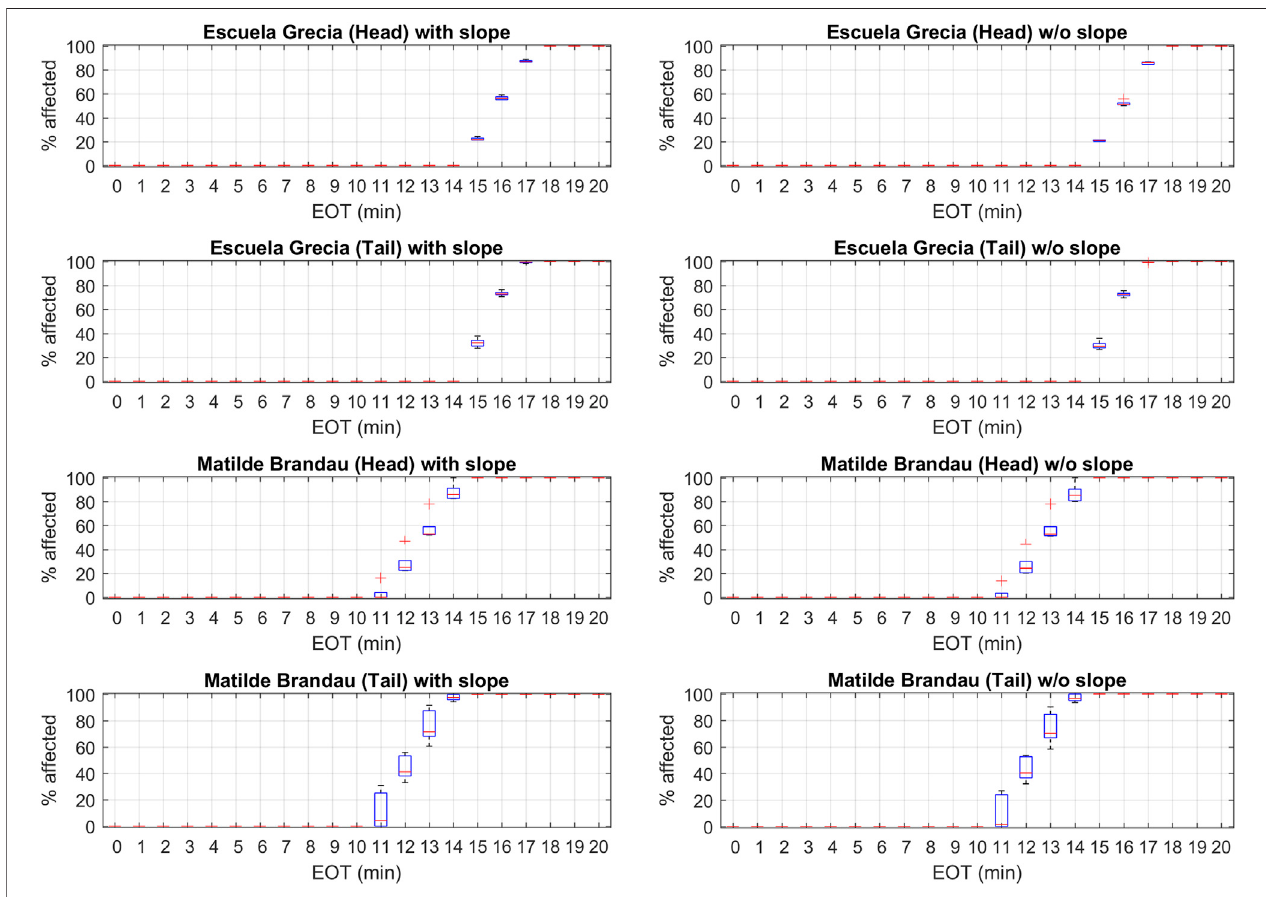
FIGURE 7 | Box plots showing the percentage of affected evacuees of the G and MB schools in Valparaíso, for evacuation speeds v1 to v5.